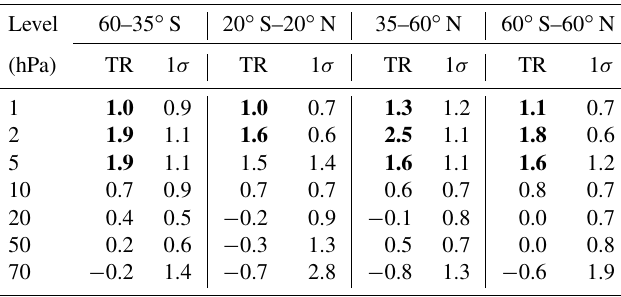
√ 3 ≈ 1 . 15 σ , i.e., statistically √ 2 ≈ 1 . 41 σ is applied as threshold